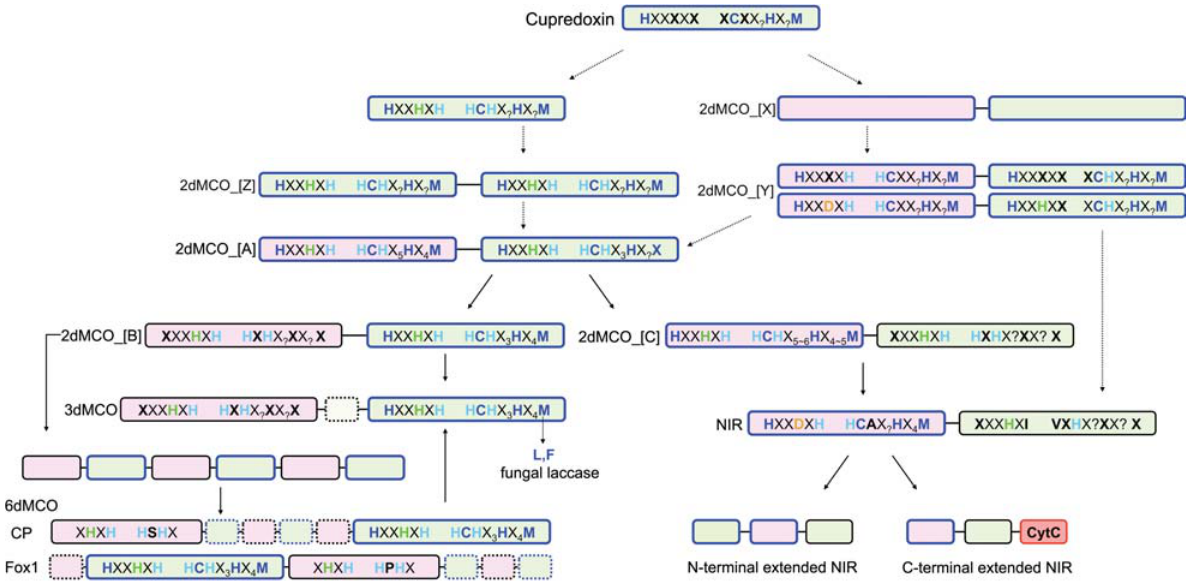
Figure 6 Proposed trajectory for the evolution of the domain structures of multicopper proteins. The first (Class IV) and second (Class V) domains are shown in pink and light green. The residues binding to the Type I copper are shown in blue. The residues binding to Type II and Type III coppers in MCOs are shown in green and cyan, respectively. The Type II coppers in NIR are shown in cyan. The catalytic Asp residue for NIR is shown in orange. Blue outlines indicate the cupredoxin-like domains containing Type I copper. Dotted outlines indicate the domains lacking the Type II and Type III ligands. The CYTC-like domain is shown in red.